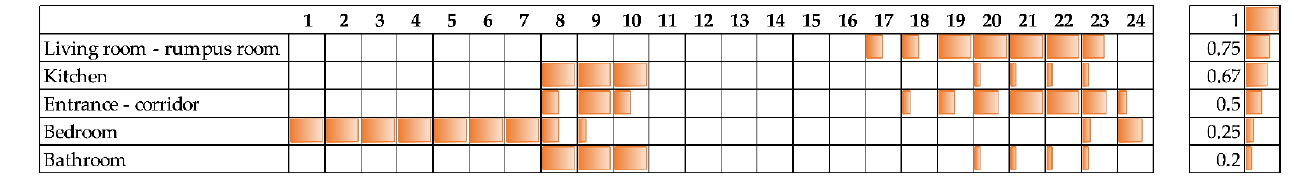
Figure 2. Reference building: ( a ) Front view—south side; ( b ) rear view—north side; ( c ) ground floor section; ( d ) basement section.